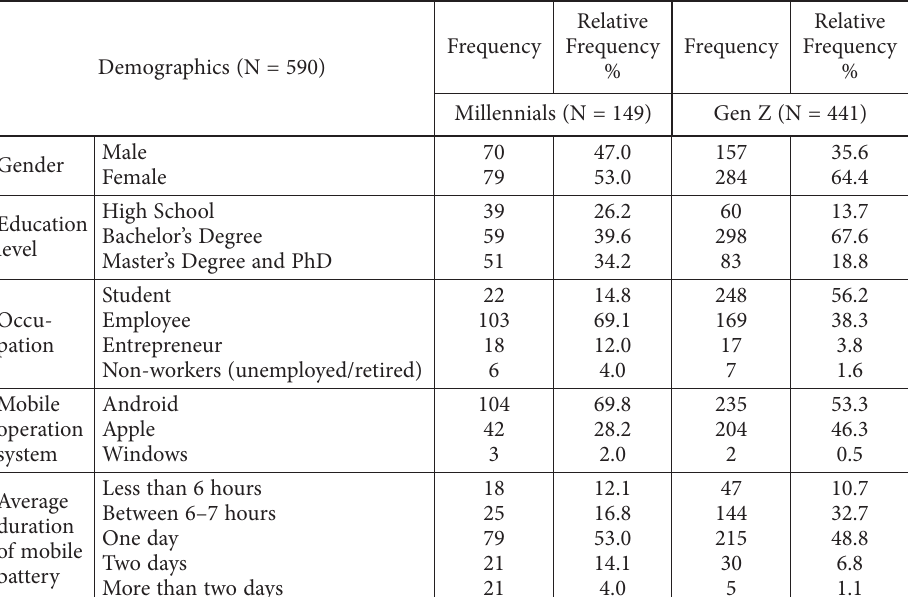
Table 1. Socio-demographics